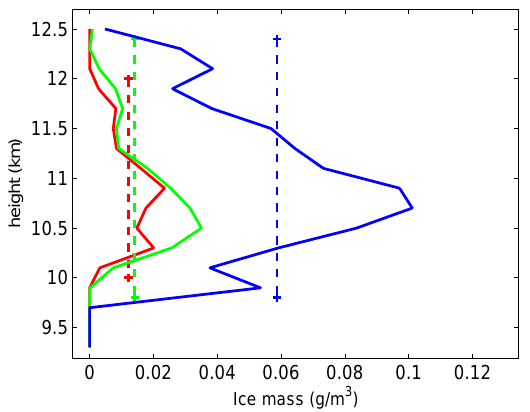
Fig. 18. Fractional difference (Inhom-Hom)/Hom between the in- homogeneous and the homogeneous cases for the three sectors, in the shortwave (top panel) and near infrared (bottom panel) MAS